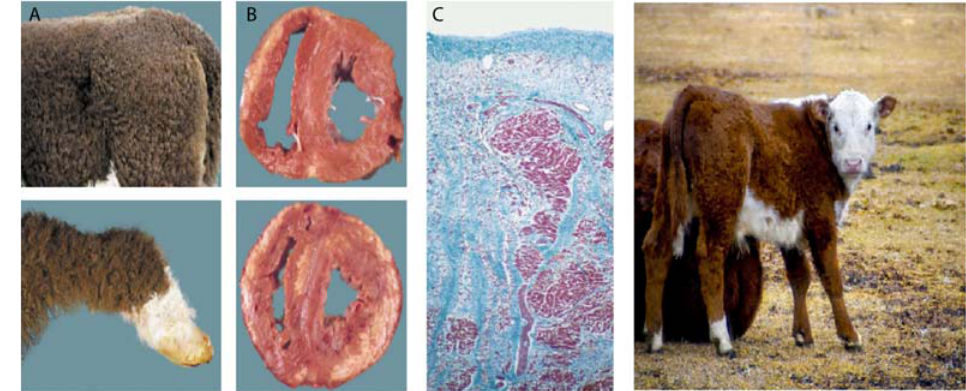
Figure 11. Cardiomyopathy/wooly haircoat syndrome (CWH) in Poll Hereford calves. (A) Distinctive wooly haircoat. (B, upper) Cross section of the heart reveals subepicardial myocardial loss with fibrous replacement of the right ventricular free wall. (B, lower) Cross section of the heart reveals the same pathologic process in both ventricles associated with calcification. (C) Right ventricular free wall with extensive subepicardial myocyte loss and replacement fibrosis embedding surviving myocytes (Masson’s trichrome stain)